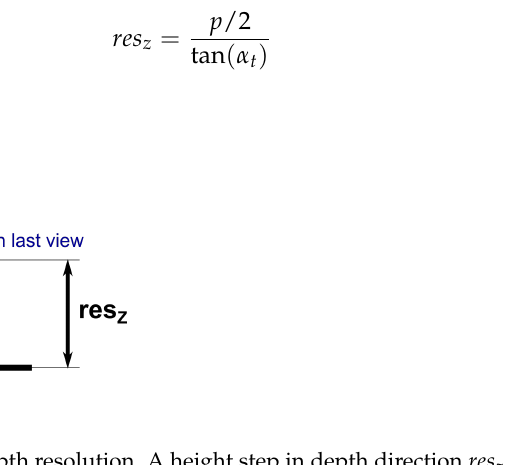
Figure 3. Estimation of the depth resolution. A height step in depth direction res z can be resolved if the parallax between the first and the last view ( ± α t ) is equal to the lateral sampling p .